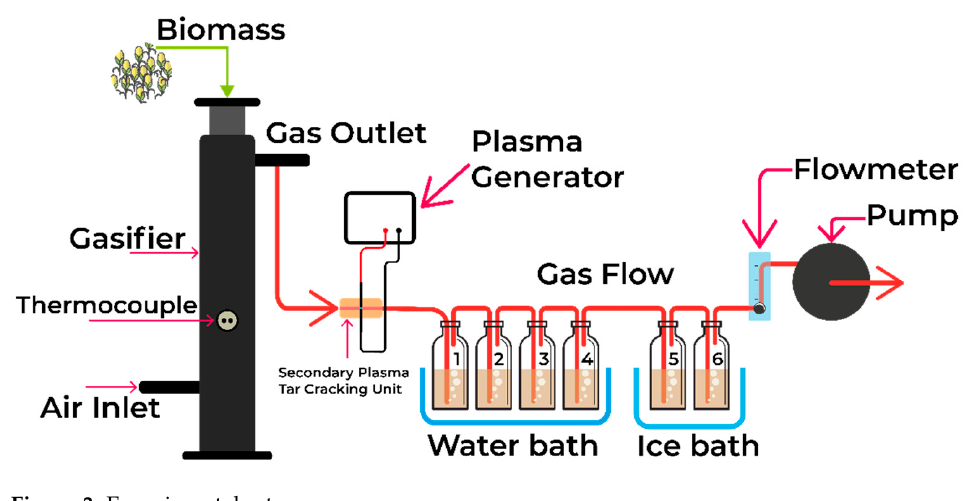
Figure 3. Experimental setup.